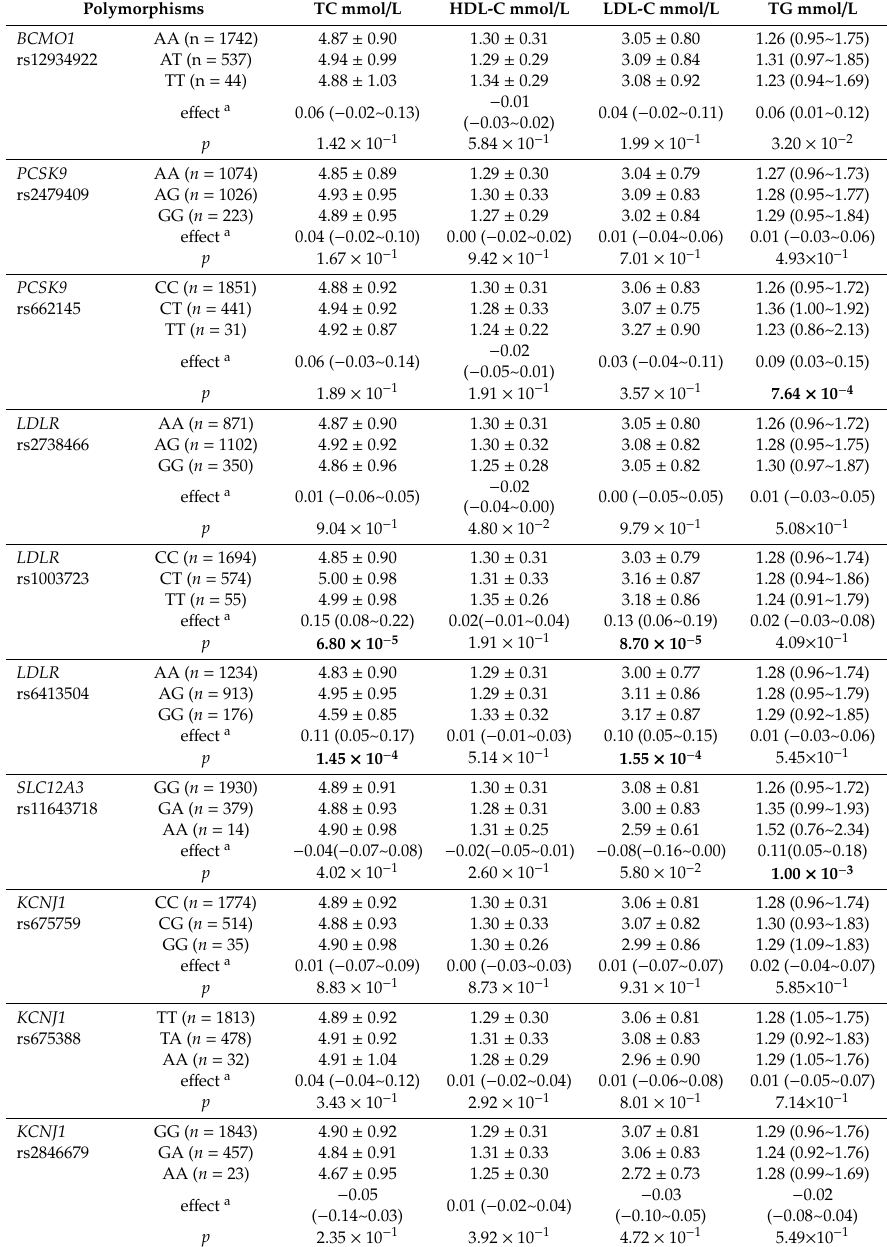
Table 3. Association of the ten SNPs with TG, TC, HDL-C, and